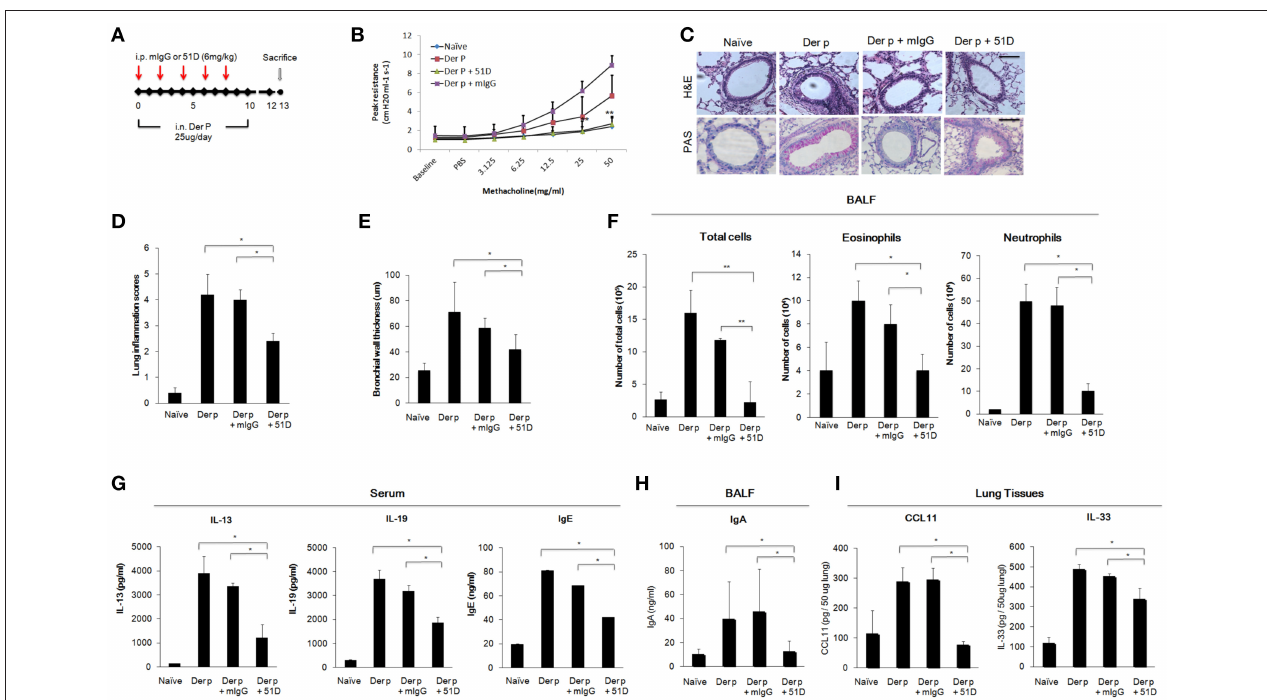
FIGURE 5 | Anti-IL-20R1 mAb (51D) reduced airway inflammation in Der p -induced asthmatic mice. (A) Protocol of Der p -induced asthmatic mouse model with anti-IL-20R1 mAb (51D) treatment. C57BL/6 mice were intranasally (i.n.) challenged with Der p extract (25 µ g/mouse/day) for 10 days to induce asthma. 51D (6 mg/kg) or control mIgG (6 mg/kg) was intraperitoneally injected into the Der p -sensitized mice on day 0, 2, 4, 6, and 8 ( n = 6 per group). (B) AHR was analyzed in the mice 3 days after the last Der p treatment. Peak AHR was methacholine dose-dependently lower in 51D-treated mice. (C) Hematoxylin and eosin (H&E) staining showed less airway thickening and periodic acid-Schiff (PAS) staining showed fewer goblet cell areas in 51D-treated mice. (D) Lung inflammation scores of the mice. (E) Bronchial wall thickness. (F) Number of infiltrated immune cells, eosinophils, and neutrophils in mouse BALF. (G) Serum IL-13, IL-19, and IgE levels in the mice. (H) BALF IgA levels. (I) CCL11 and IL-33 levels in the lung tissues. * P < 0.05, ** P < 0.01 by one-way non-parametric